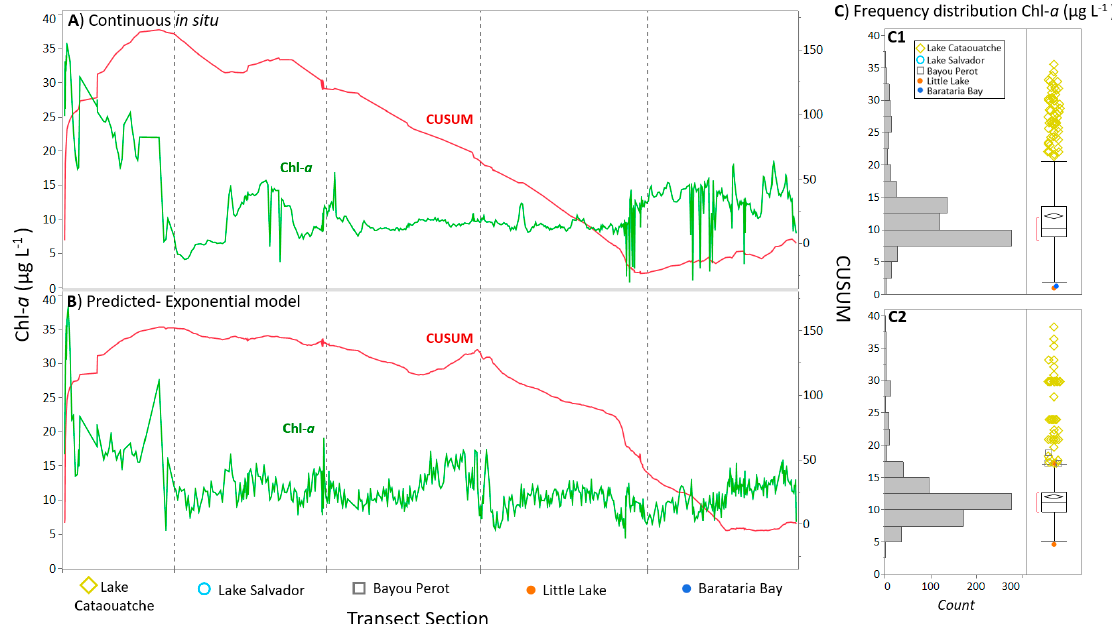
Figure 10. Chl- a values (green line, left vertical axis) and cumulative sum (CUSUM; red line, right vertical axis) of Chl- a values. ( A ) continuous in situ Chl- a ( B ) exponential model predictions of Chl- a . CUSUM values with positive slope indicate that [Chl- a ] values were above the spatial series average, and vice versa. ( C ) Chl- a distribution frequency for (C1) continuous in situ Chl- a and (C2) exponential model predicted Chl- a